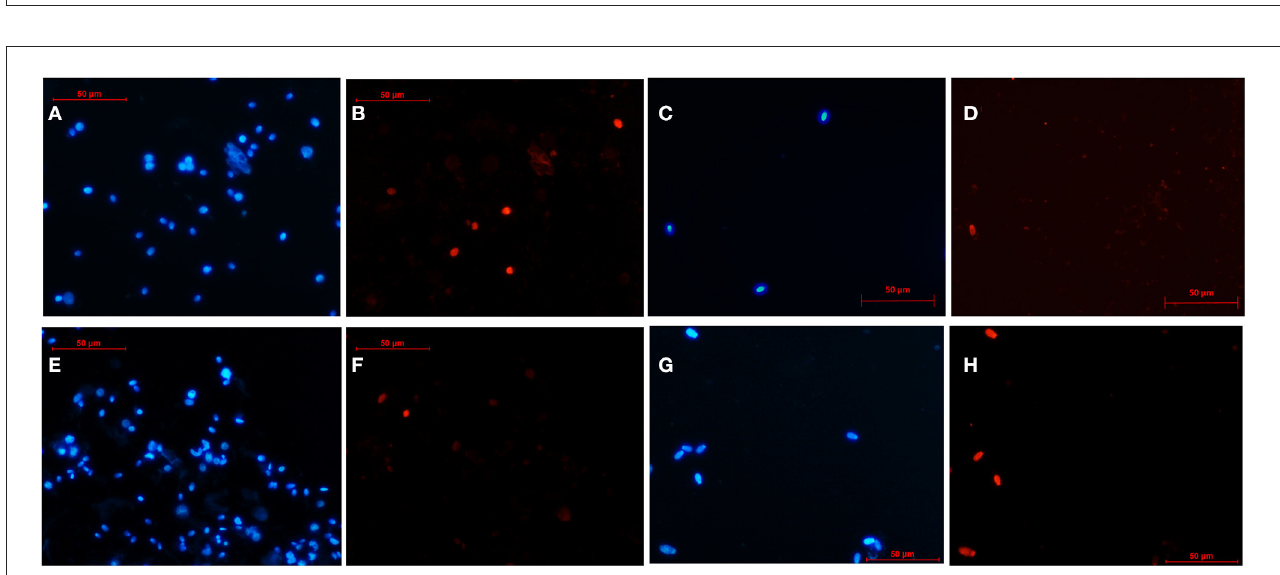
FIGURE3 Representative images of the DNA integrity of testicular cells after slow freezing-thawing (A–D) and after vitrification-warming (E–H) . The nucleus of testicular cells was stained with Hoechst (blue fluorescence) and those showing DNA fragmentation also emitted red fluorescence (TUNEL + ). Rounded and elongated germ cells from a primate (Capuchin monkey) after slow freezing-thawing (A, B) , spermatozoa from a rodent (Patagonian mara) after slow freezing-thawing (C, D) , rounded and elongated germ cells from a carnivore (Suricata) after vitrification-warming (E, F) , spermatozoa from an artiodactyl (Iberian ibex) after vitrification-warming (G, H)